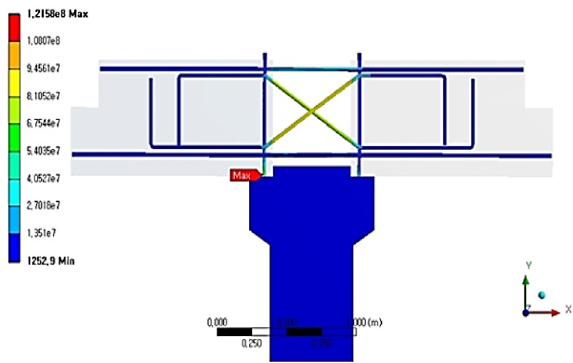
Fig. 26. Location of maximum stress at an eccentric load of 136 kN